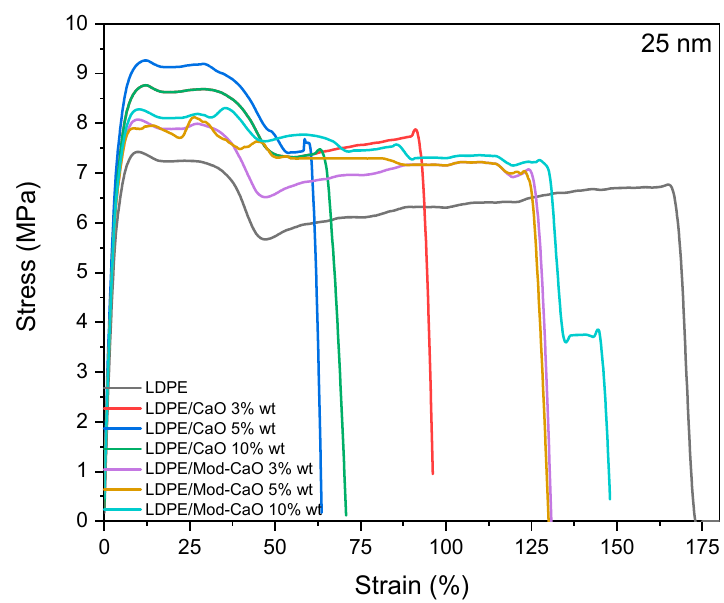
Figure 7. Stress–strain curves of LDPE, LDPE/CaO, and LDPE/Mod-CaO with CaO nanoparticles ca. 55 nm.